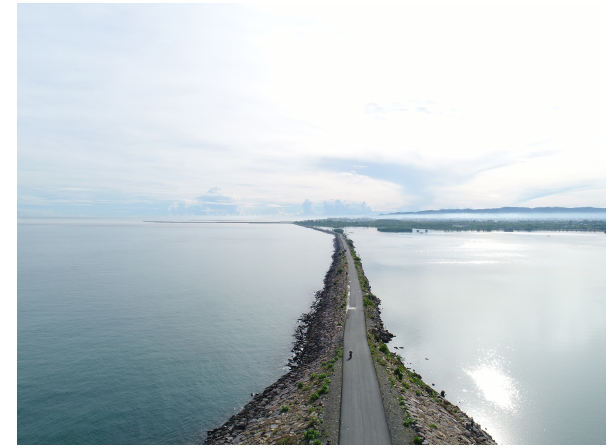
Figure 3. A 7km embankment along the coast of Banda Aceh and a road which was constructed at its leeward side (date photo taken: February